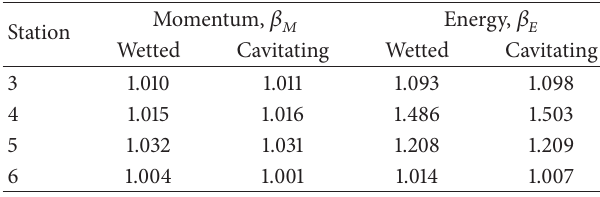
Figure 8: Computational domain and polyhedron-based unstruc- tured grid used for waterjet computations.